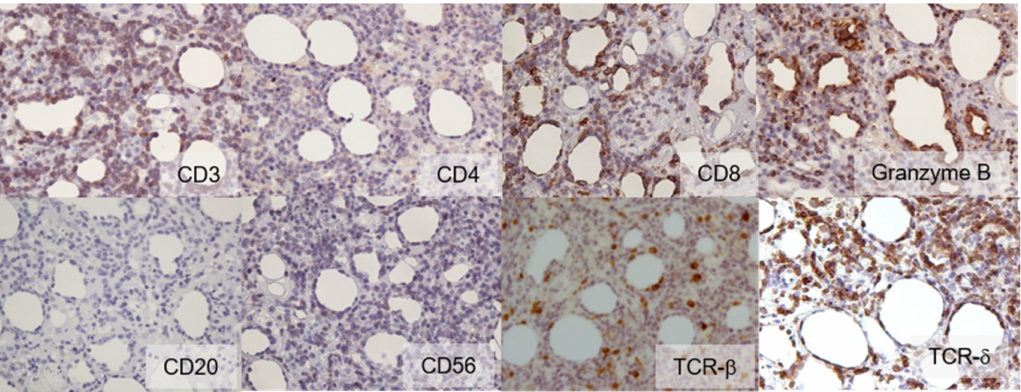
Figure 3. Immunohistochemistry ( × 400). Atypical lymphoid cells showed the following expression profile: CD3 (+), CD4 ( − ), CD8 (+), granzyme B (+), CD20 ( − ), CD56 ( − ), TCR- β ( − ), and TCR- δ